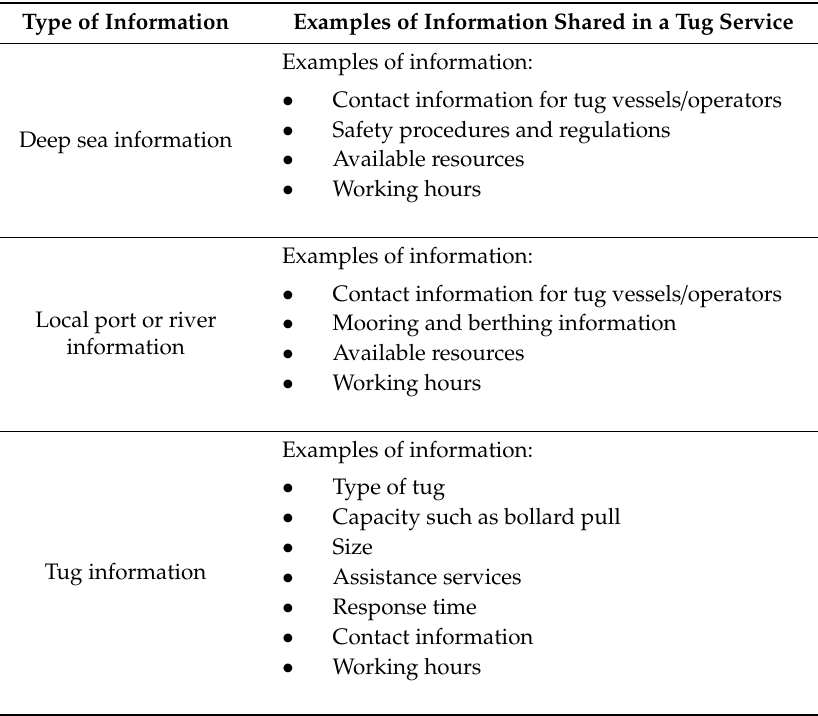
Table 5. Examples of information shared in a tug service